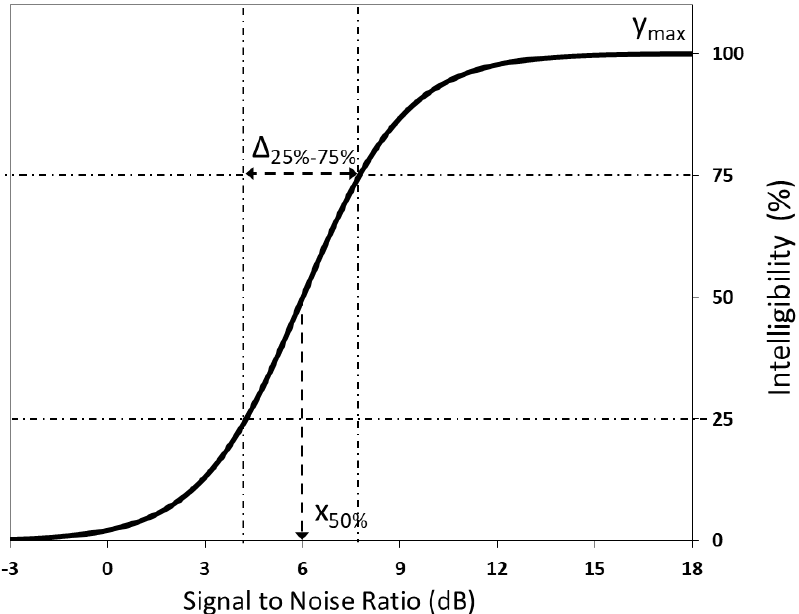
Figure 2. Fitting of the recognition percentages by a sigmoid curve.